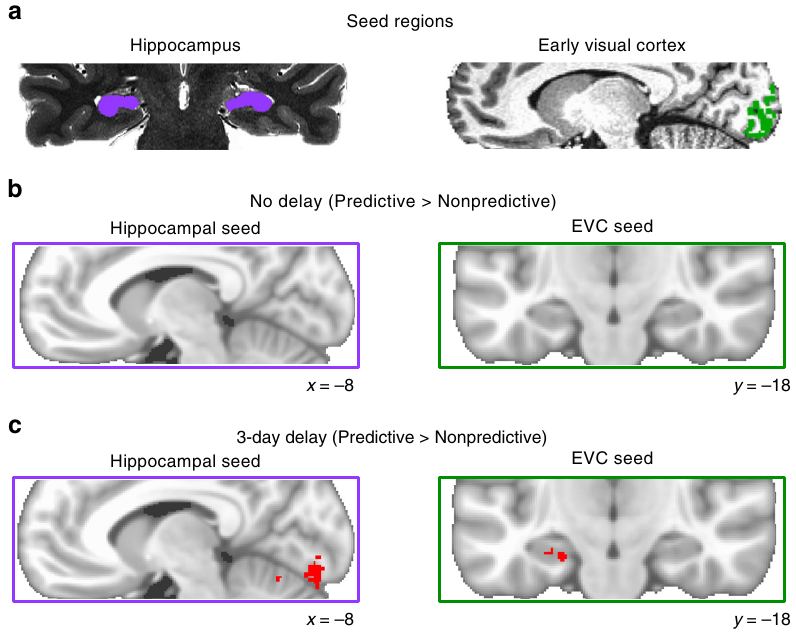
Fig. 4 Voxelwise background connectivity. a Hippocampal and EVC seed regions were de fi ned on high-resolution anatomical scans. The hippocampal seed and ROI included CA2/3, dentate gyrus, and CA1 (but not the subiculum) since these sub fi elds were linked to pattern completion during action-based prediction in a prior study with the same task 3 . EVC was limited to voxels in V1/V2 that were responsive to the experimental stimuli in a separate functional localizer. b Predictiveness did not reliably modulate hippocampal or EVC background connectivity anywhere in the fi eld of view immediately after training. c However, we observed several clusters of enhanced background connectivity after the 3-day delay, including bilateral V1 and V2 for the hippocampal seed, and anterior and posterior left hippocampus for the EVC seed. Contrasts are visualized on the MNI152 template and corrected at p < 0.05 (TFCE) for the partial volume of functional scans outlined by purple/green